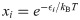
States and their weights in the simple repression architecture.All allowed states of the simple repression architecture are shown with their associated energies and statistical weights. ϵP is the binding energy of the RNAP onto the promoter site, ϵR the binding energy of a repressor molecule onto the operator site. The third column shows the grand canonical weights, where the λi is the fugacity of the RNAPs (i = P) or repressors (i = R), and xi=e-ϵi/kBT. The right column lists the weights in the canonical ensemble where P is the number of RNA-polymerase molecules, R the number of repressors, and Nns the number of non-specific binding sites of the genome.